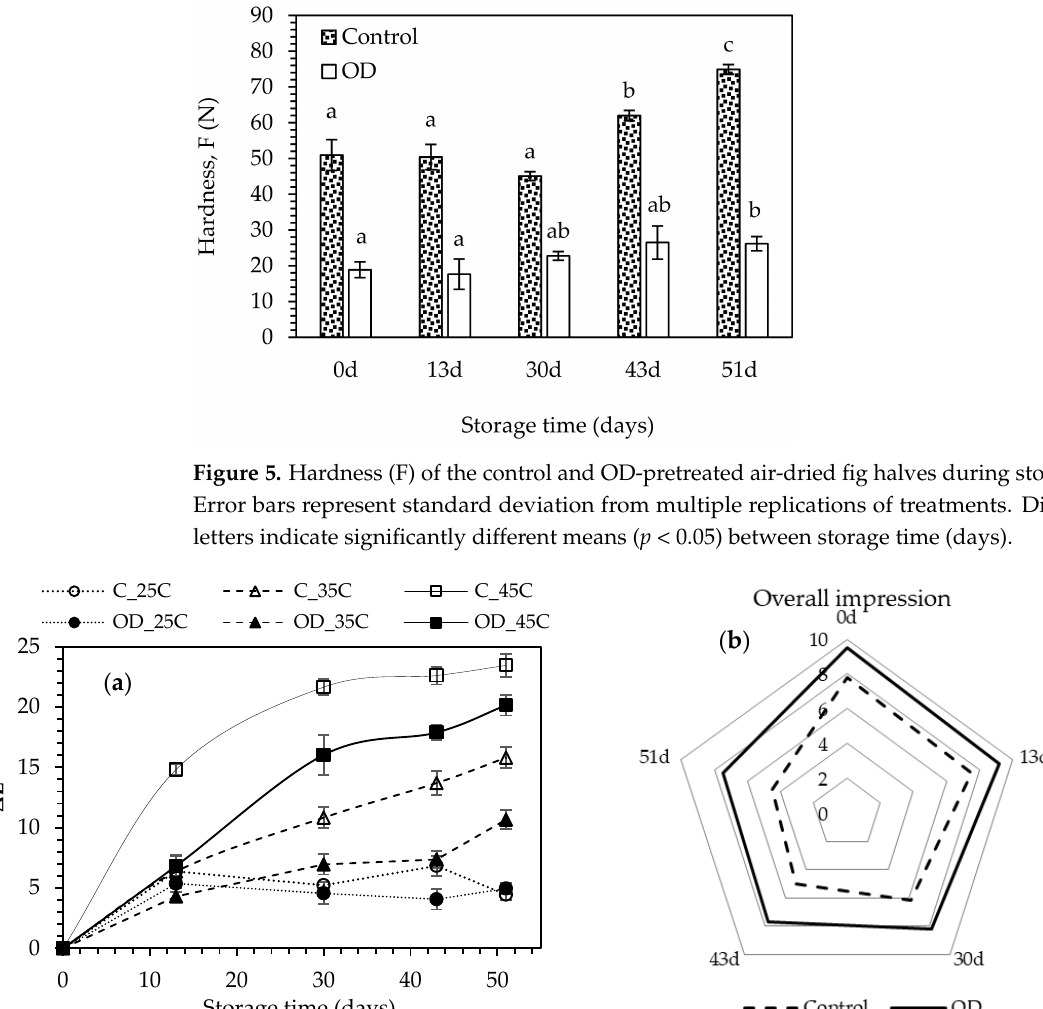
Figure 5 . Hardness (F) of the control and OD-pretreated air-dried fig halves during storage at 45°C. Error bars represent standard deviation from multiple replications of treatments. Different small letters indicate significantly different means ( p < 0.05) between storage time (days).